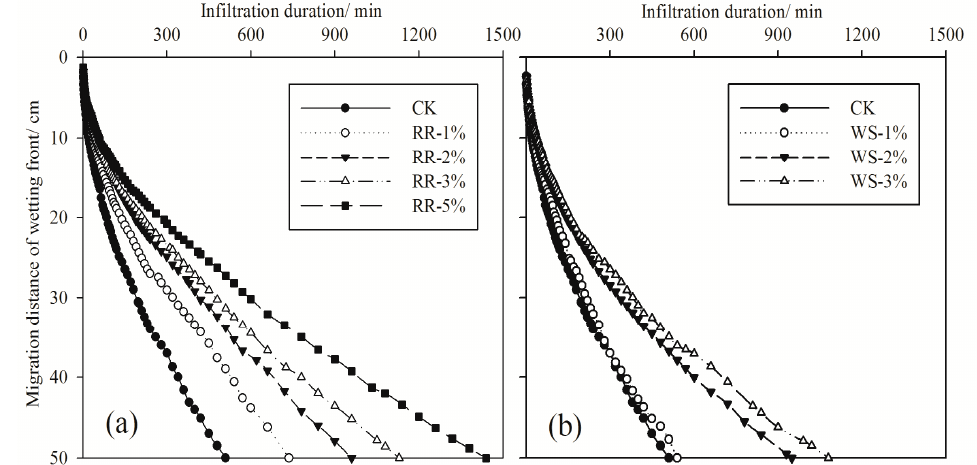
Figure 1. Relationship between migration distance of the wetting front and duration with various quantities of applied rapeseed-oil residue (RR) and wheat straw (WS): ( a ) Represents the treatments mixed with RR; ( b ) Represents the treatments mixed with WS.